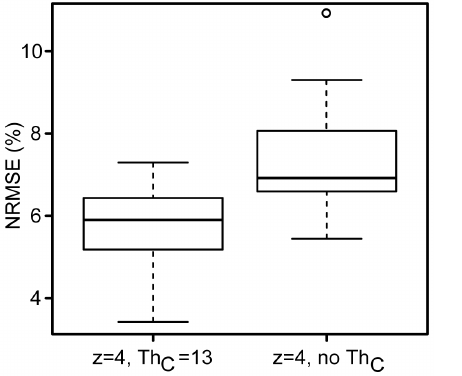
Figure 9. Distribution of normalized root mean square error (NRMSE) of the optimization results for experiments with consistency threshold (Th C =13) and without. Adding a Th C improves the NRMSE significantly. The horizontal lines of each box are the lower quartile, median, and upper quartile values (from bottom to top). The whiskers represent the most extreme values within 1.5 times the interquartile range from the quartile. The outlier (circle) is a value beyond the interquartile range.